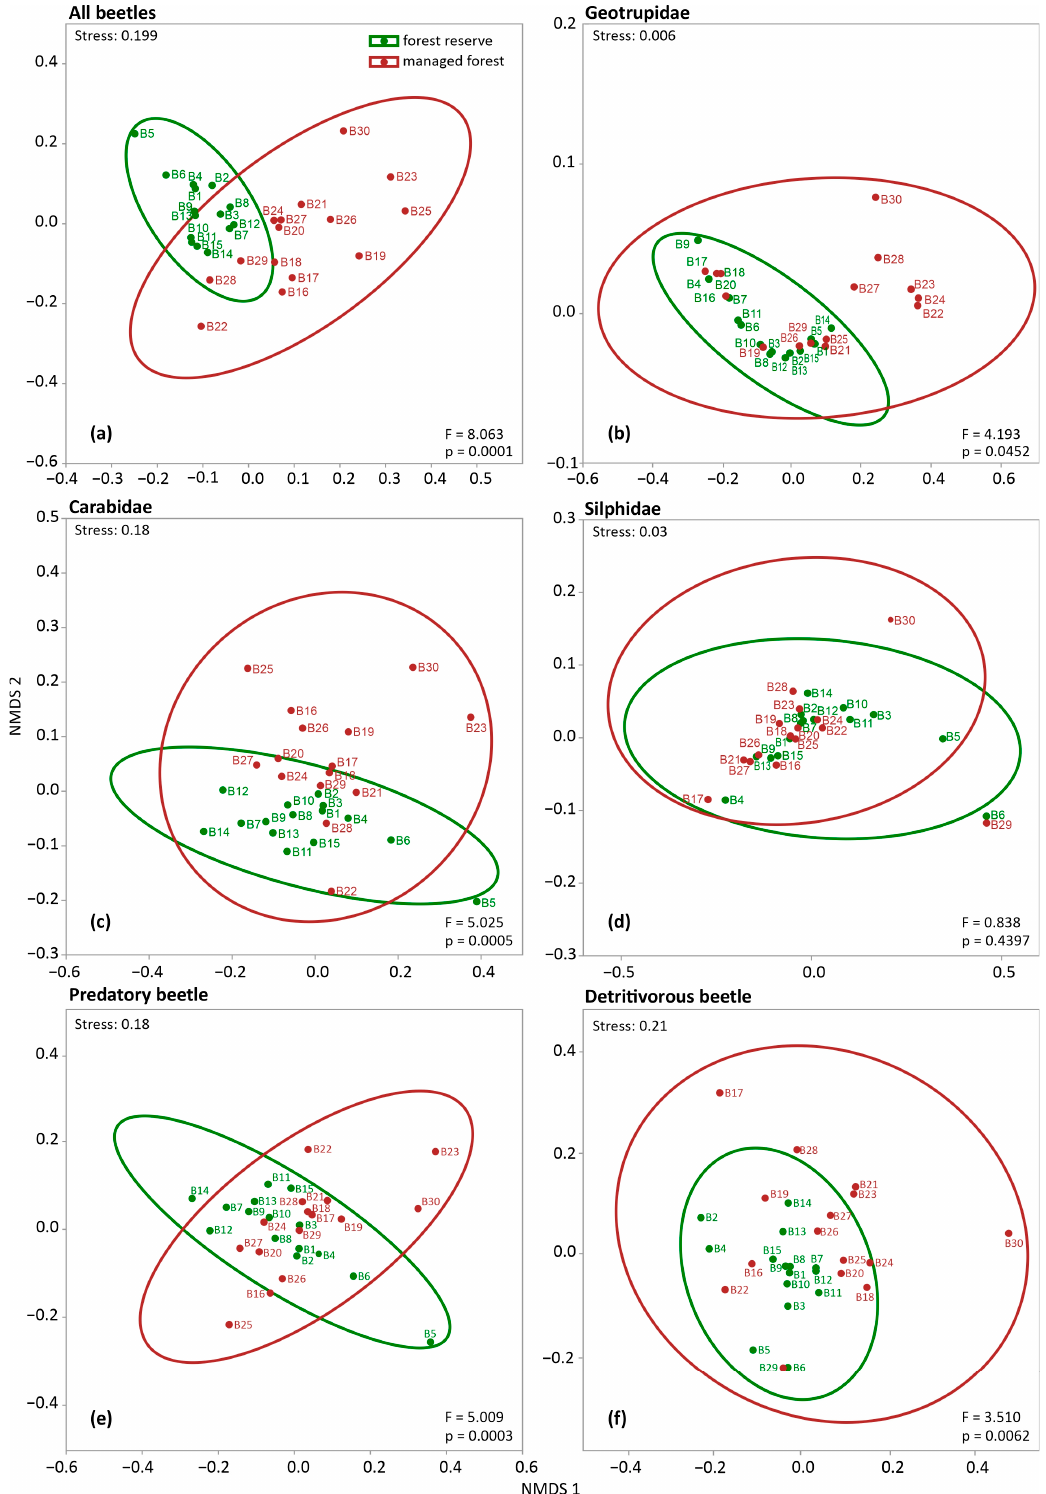
Figure 7. Non-metric, multidimensional scaling (NMDS) of Bray–Curtis distances of sampled beetle communities according to stand type (forest reserve and managed forest) and all beetles captured ( a ), Geotrupidae beetles ( b ), Carabidae beetles ( c ), Silphidae beetles ( d ), and two trophic guilds, the predatory ( e ) and the detritivorous group ( f ). Pairwise PERMANOVA with 999 permutations (using pseudo-F ratios) was used for all comparisons.